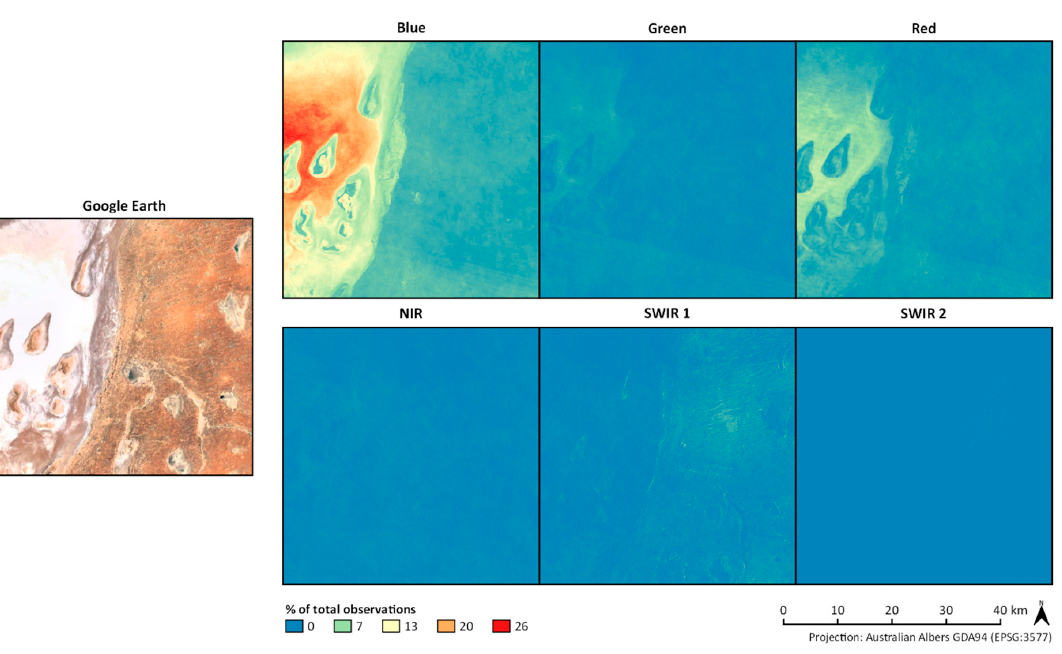
Figure 10. High-resolution imagery (Google, DigitalGlobe, CNES/Airbus), saturation flags in the visible, NIR, and SWIR bands in percent of total observations; Lake Frome, SA.